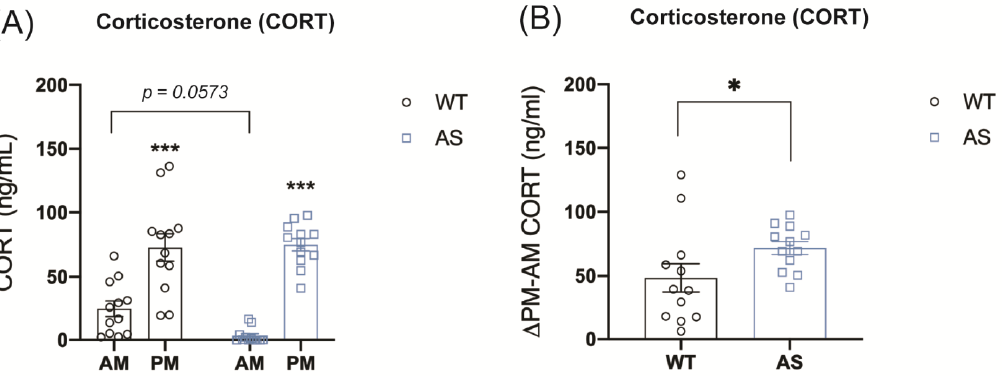
Figure 2. UBE3A deficiency in AS mice alters circulating corticosterone levels. ( A ) Circulating corticosterone levels in WT and AS mice at the beginning of the resting phase (AM) and the active phase (PM) (ng/mL). ( B ) Difference between PM and AM corticosterone plasma levels in WT and AS mice (ng/mL). * p < 0.05; *** p <